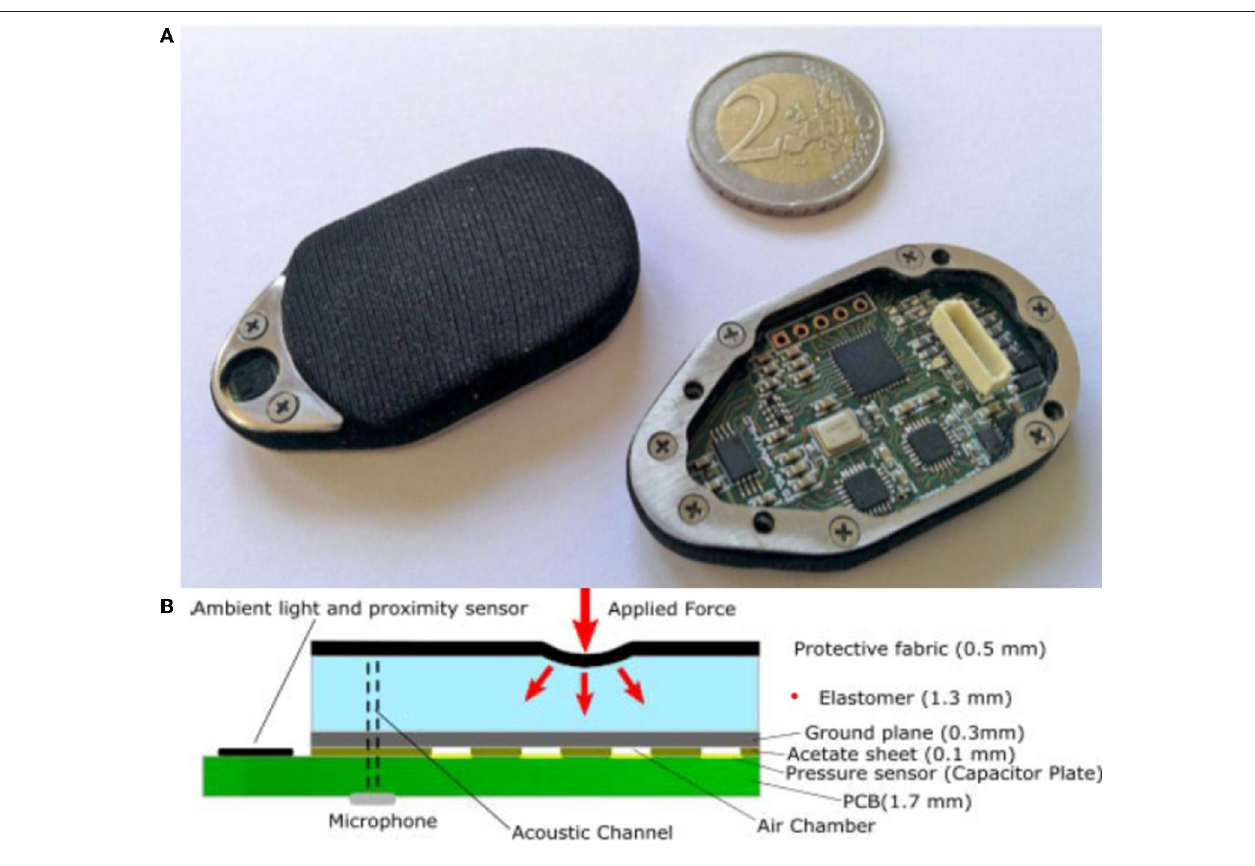
FIGURE 1 | (A,B) Illustration of CPM-Finger tactile sensor (Denei et al., 2017).